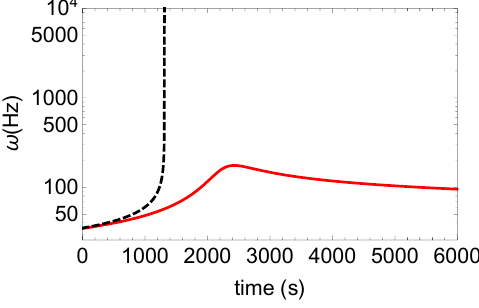
Figure 5 . Angular frequency as a function of time for a pair of inspiraling neutron stars where the axion force is stronger than gravity and repulsive. The black dashed curve shows the result for uncharged neutron stars while red shows the result for neutron stars with a charge. The frequency increases until the radius of the orbit is r (cid:24) 1 =m a , where the repulsive force turns on and the frequency starts to